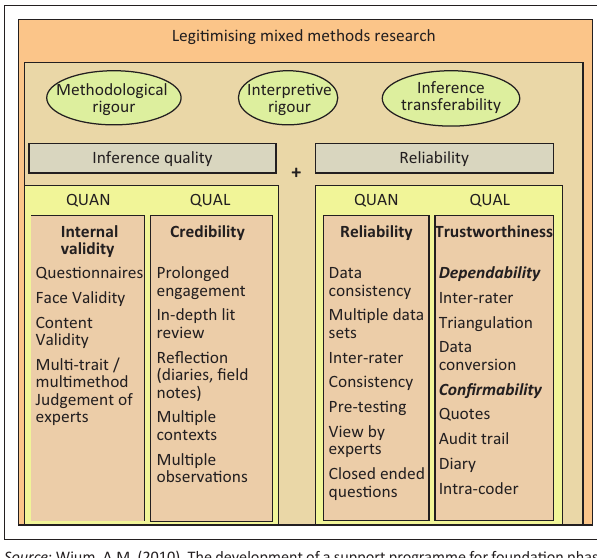
FIGURE 2: Aspects related to legitimising the